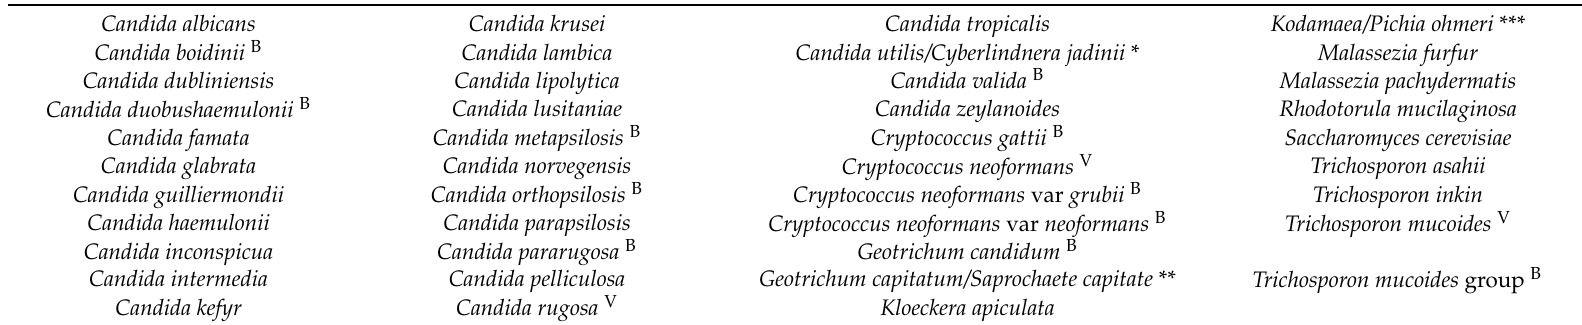
Table 1. Reportable yeasts for the FDA-approved/cleared Vitek MS and MALDI Biotyper CA systems as of October 2018 [13]. Those entries marked with “ V ” are FDA-approved/cleared for the Vitek MS system only and those marked with “ B ” are FDA-approved/cleared for the MALDI Biotyper CA system only. Those with marked with neither a “ V ” nor a “ B ” are FDA-approved/cleared on both systems.